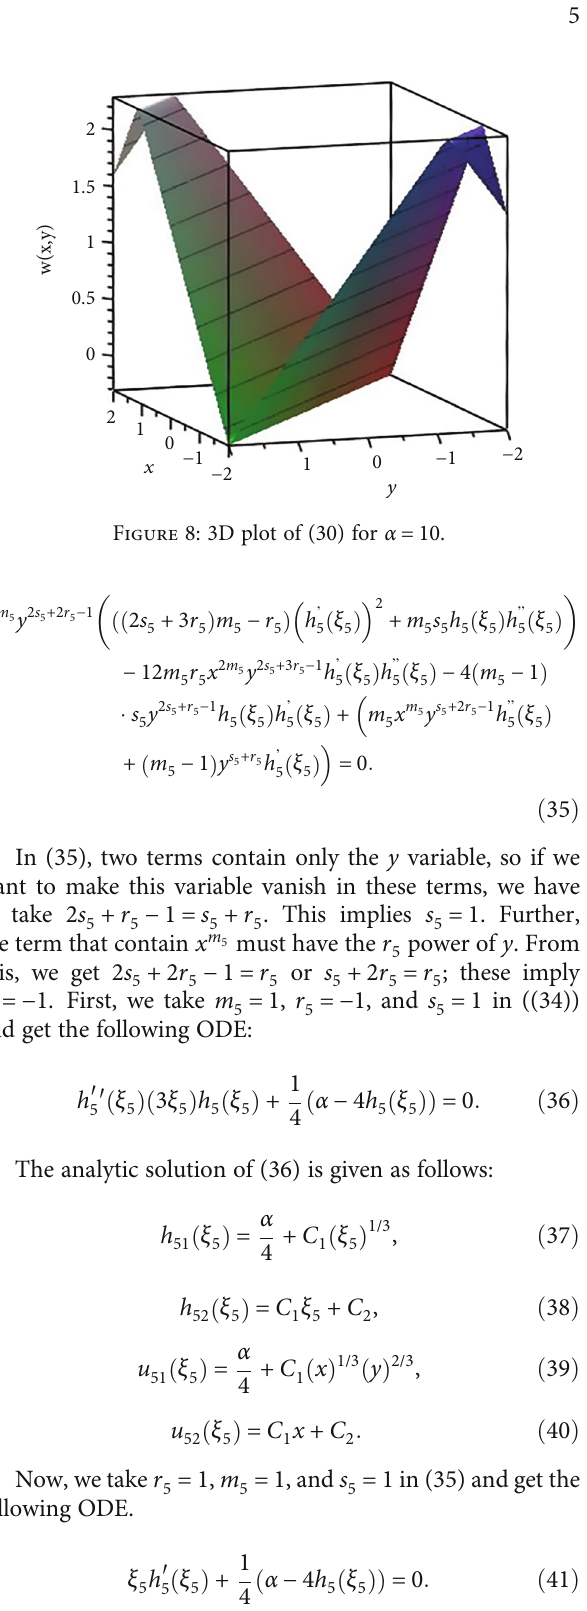
Figure 8 acts as the solution of (1) which is given in (30).